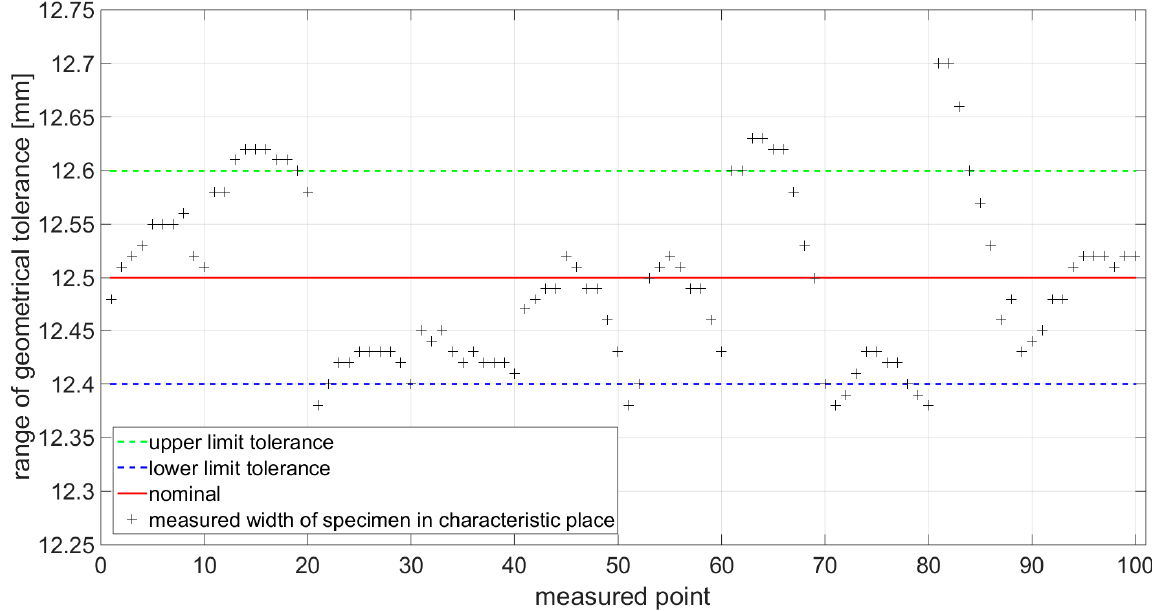
Figure 12. Measured values for specimens with 0° orientation of the material fibers.